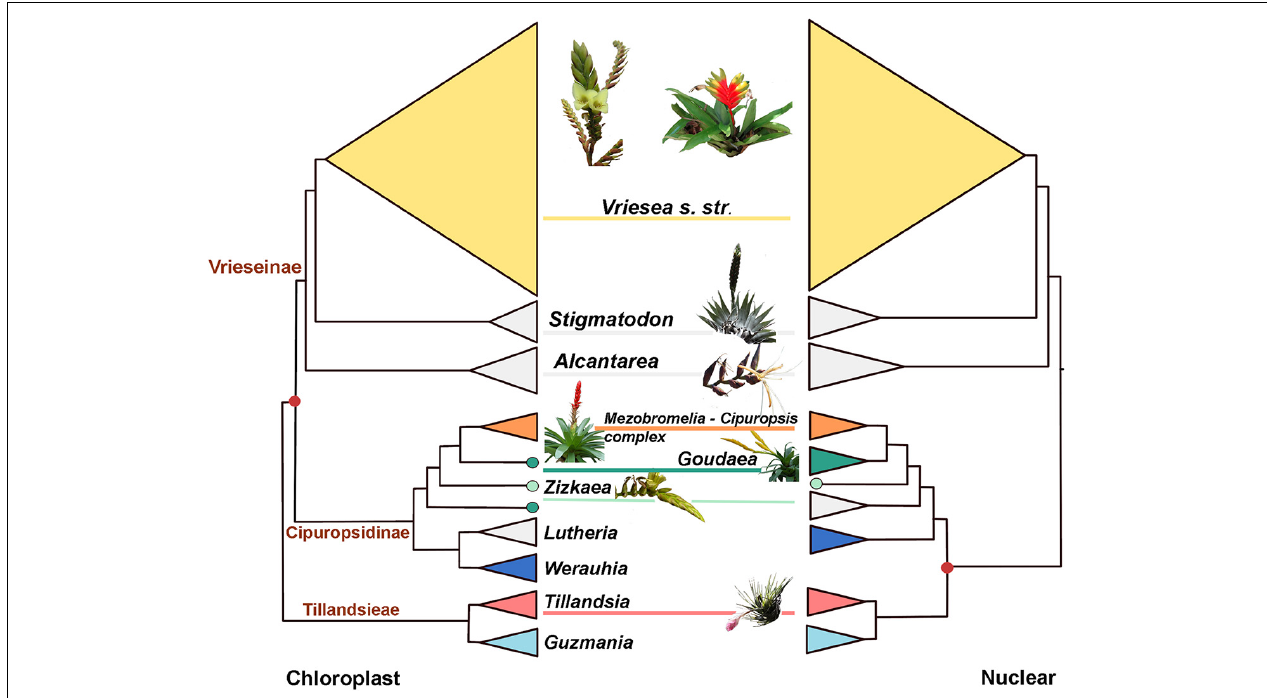
FIGURE 1 | Phylogenetic incongruence in core Tillandsioideae. Summary cladograms of the chloroplast (left) and nuclear (right) phylogenetic trees. The red dot indicates the incongruent node associated with the placement of subtribe Cipuropsidinae. Genera indicated as follow (from up to down): V. s. str. , Vriesea sensu stricto; Sti , Stigmatodon; Alc , Alcantarea; Cip- Mez , Vriesea—Cipuropsis/Mezobromelia complex; Gou , Goudeae; Ziz , Zizkaea; Lut , Lutheria; Wer , Werauhia; Till , Tillandsia; Guz , Guzmania. Colors indicate genera where hybrids were detected (see Figure 2 ). Photos by Eric Gouda ( Goudaea, Mezobromelia and Zizkaea ) and Talita Mota Machado ( Alcantarea, Stigmatodon, Tillandsia and Vriesea s. str .).